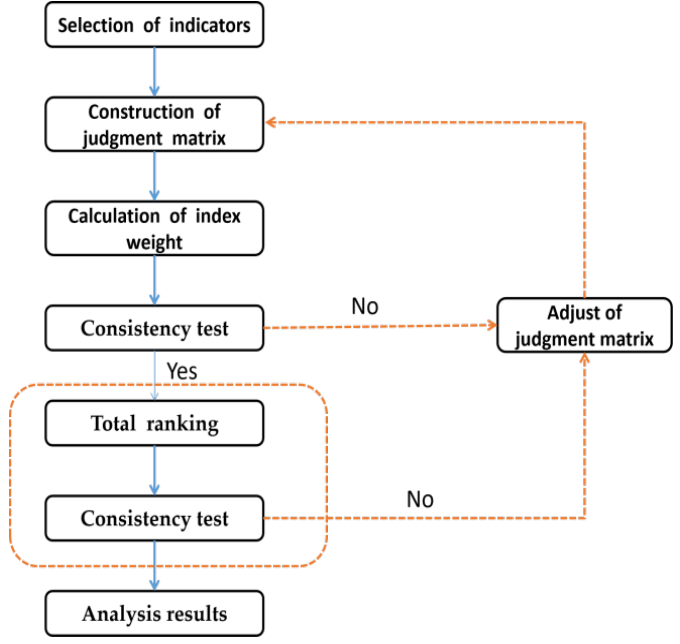
Figure 18. The AHP analysis process.